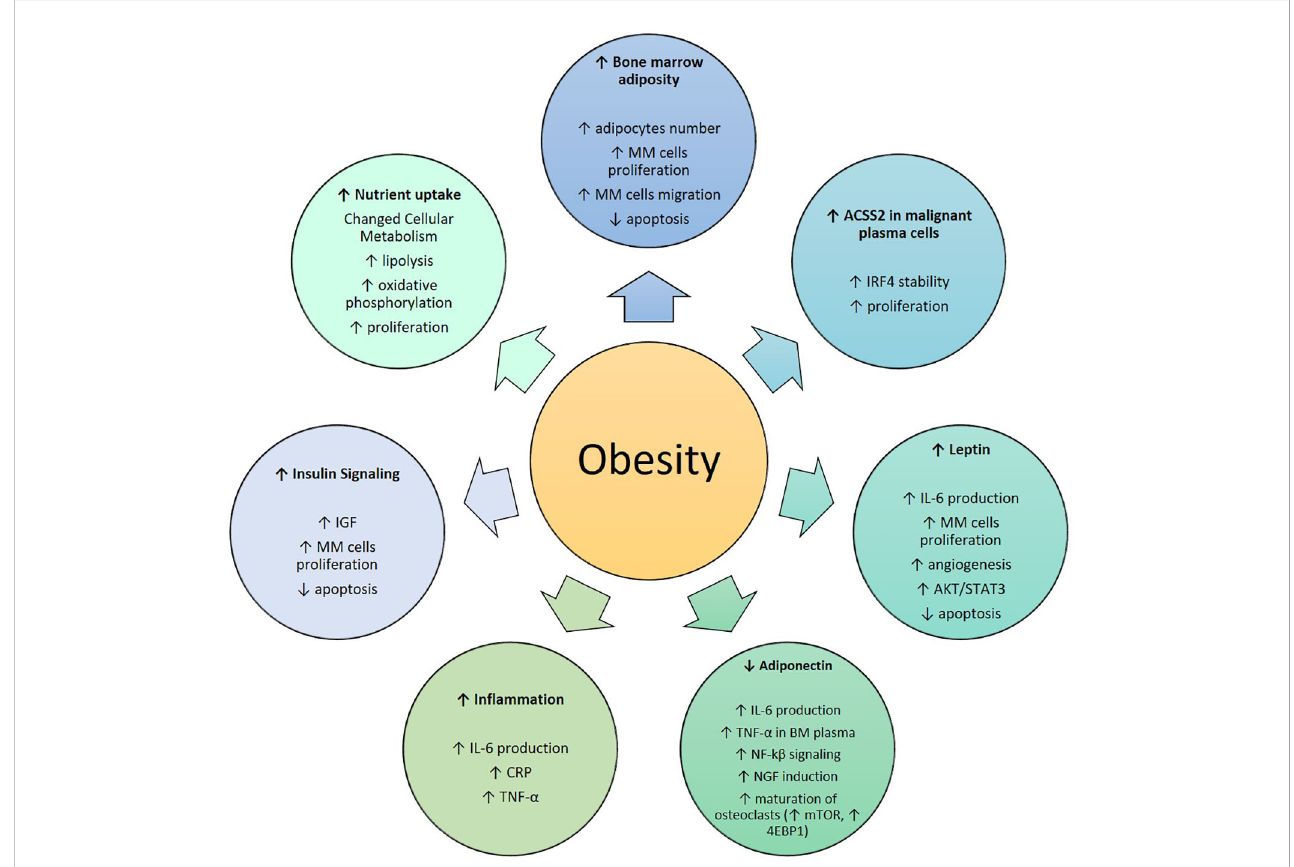
FIGURE 2 Role of obesity in MultipleMyeloma: MM, MultipleMyeloma; ACSS2, Acetyl-CoASynthetase2;IRF4, InterferonRegulatoryFactor4;IL-6, Interleukin-6;AKT/STAT, ProteinKinaseB/Signal TransducerandActivatorof Transcription;TNF- a ,TumorNecrosisFactor- a ;NF-k b , NuclearTranscription Factork b ;NGF,Nerve Growth Factor;mTOR,Mechanistic/MammalianTarget of Rapamycin;4EBP1, EukaryoticTranslationInitiationFactor4E-BindingProtein;CRP,